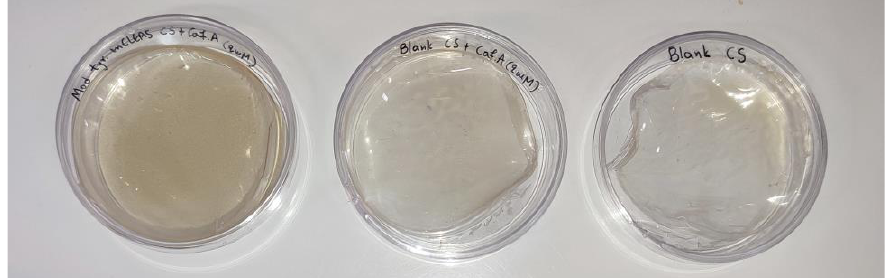
Figure 9. Photographs of a mCLEAs-modified chitosan film with caffeic acid ( left ), a blank chitosan film with caffeic acid ( middle ) and a neat chitosan film ( right ).